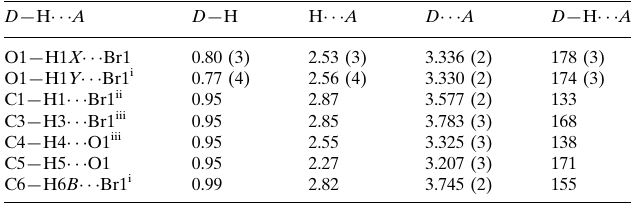
Hydrogen-bond geometry (A˚ , (cid:3)